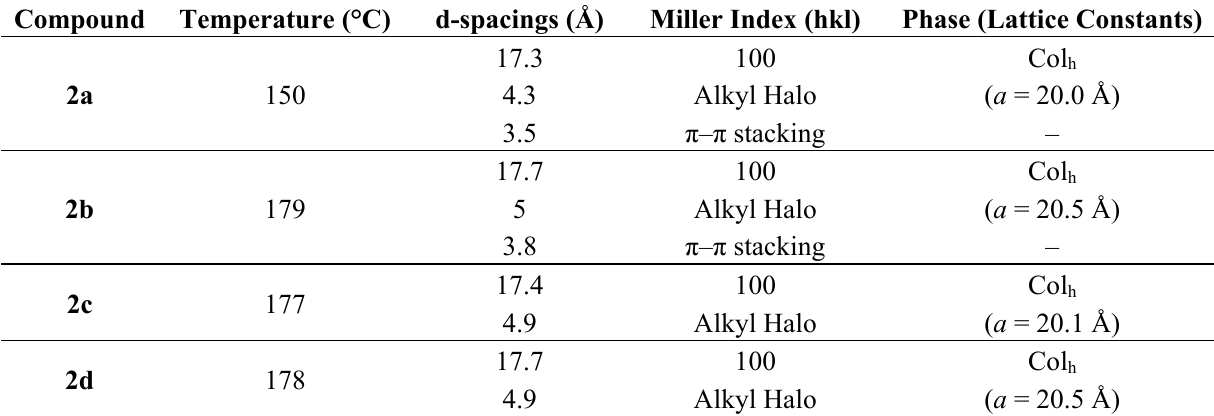
Table 2. X-ray diffraction (XRD) data and lattice constants for compounds 2 – 7 .